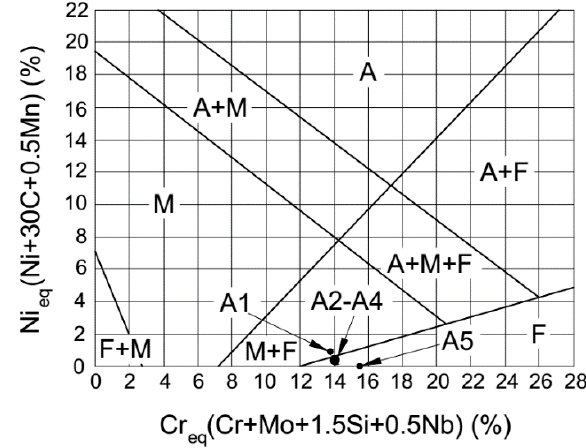
Figure 8. Ferrite and martensite distribution of the deposited samples on the Schaeffler diagram.